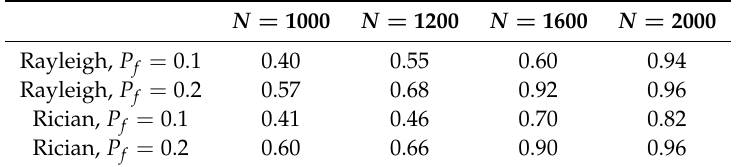
Table 6. Detection probabilities of different numbers of sampling points when the SNR = − 16 dB. N = 1000 N = 1200 N = 1600 N = 2000 Rayleigh, P f = 0.1 0.40 0.55 0.60 0.94 Rayleigh, P f = 0.2 0.57 0.68 0.92 0.96 Rician, P f = 0.1 0.41 0.46 0.70 0.82 Rician, P f = 0.2 0.60 0.66 0.90